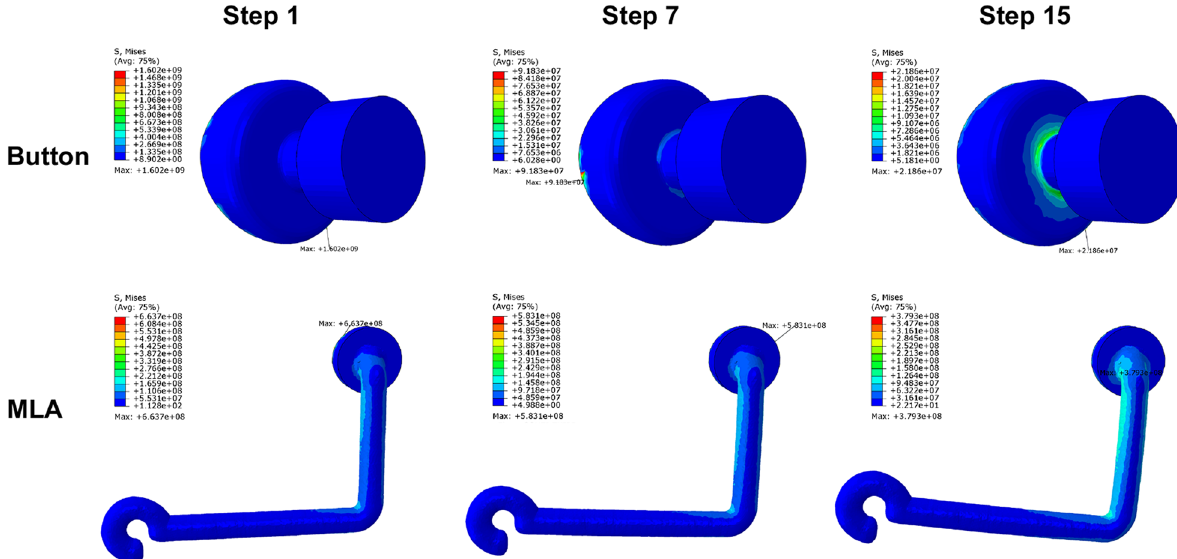
Fig. 6 Von Mises stress (Pa) of button and MLA at the beginning, intermediate, and final